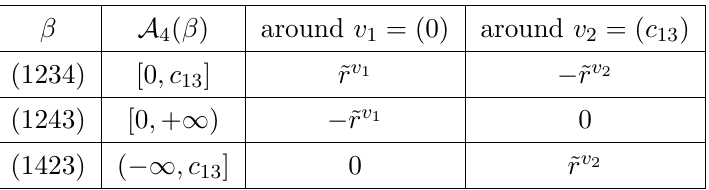
Table 5 . Ray one-forms describing associahedra for n = 4 in the neighbourhood of each vertex in V . 4